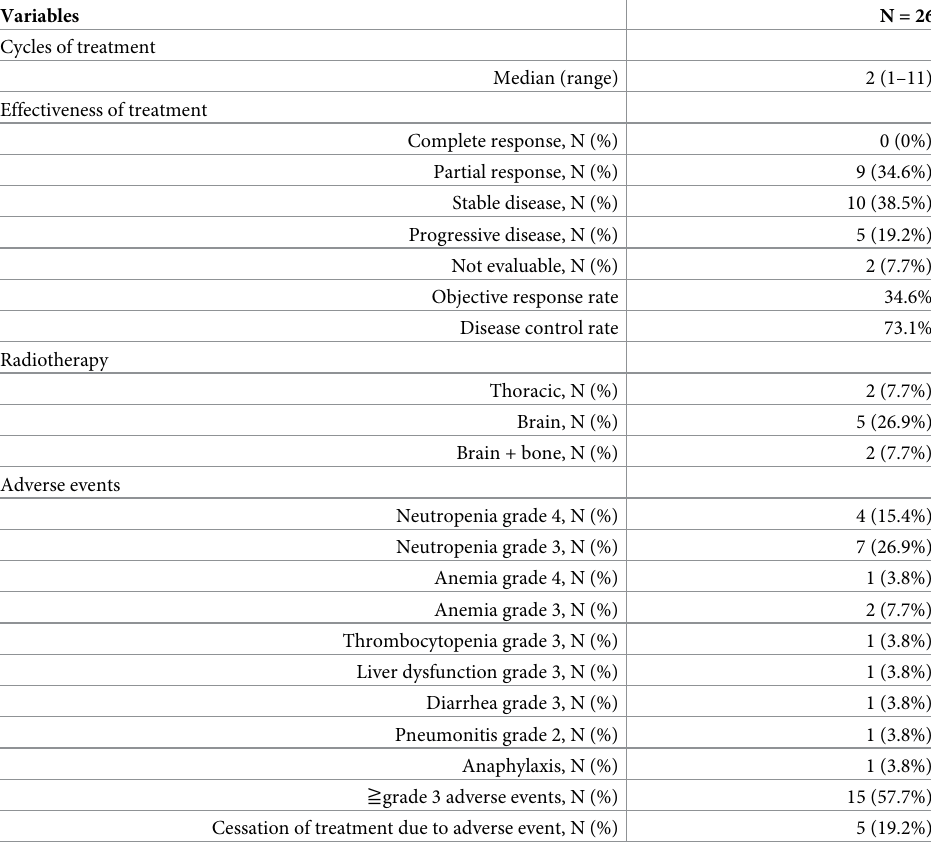
Table 2. Treatment results.